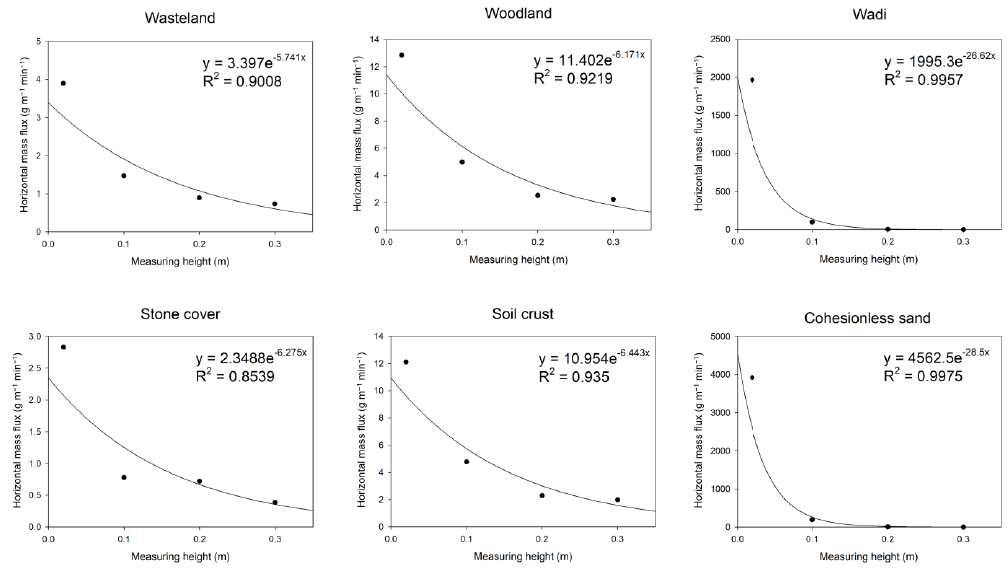
Figure 7. Exponential decay functions fitted to vertical distribution of horizontal mass flux.